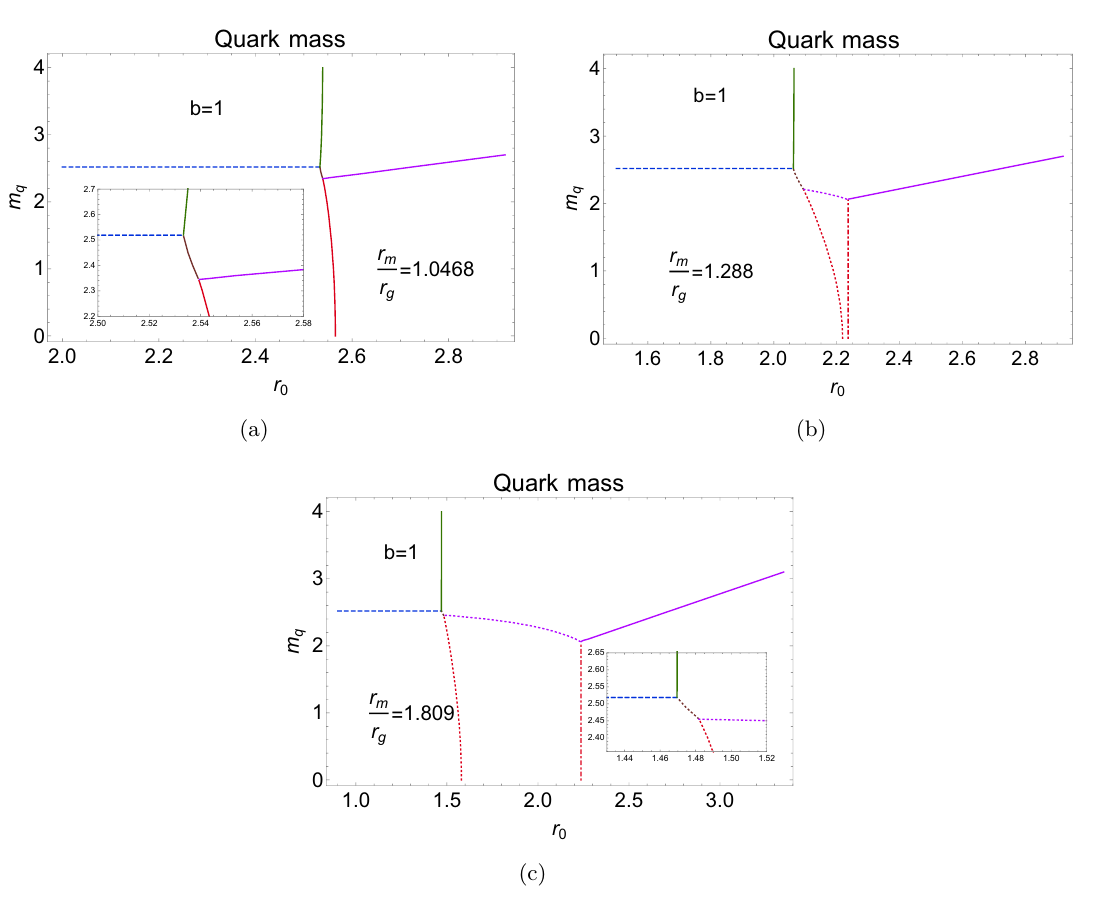
Figure 22 . Phase diagram for varying the ratio r m